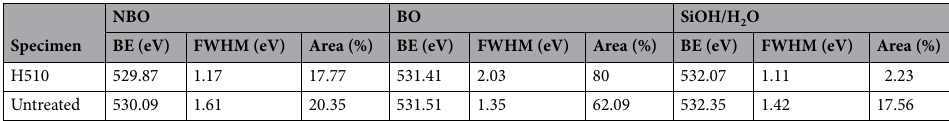
Table 1. Binding energy, FWHM and % area of deconvoluted O1s peaks of untreated and heat-treated surfaces.